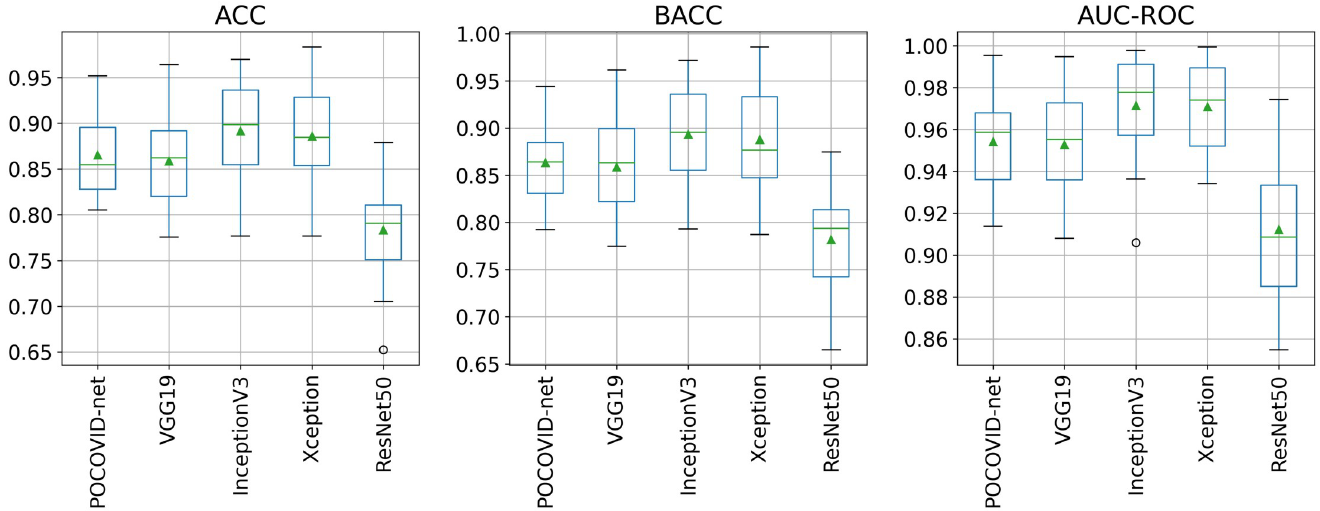
Fig 5. 5 × 5-fold cross-validation results: ACC, BACC, and AUC-ROC ACC, BACC, and AUC-ROC scores boxplots. Box extends from the Q1 to Q3 quartile values of the data, with a line at the median and a triangle at the mean.